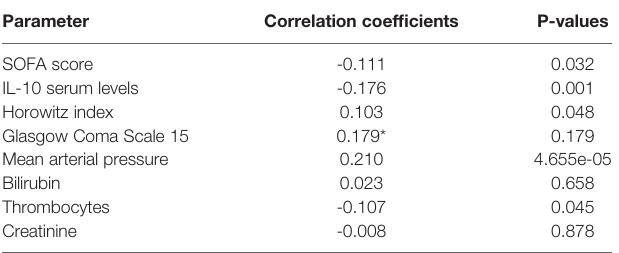
TABLE 1 | Correlation coef fi cients and p-values for the correlation of KLF4 gene expression levels in peripheral blood with SOFA score, SOFA subscores and serum levels of IL-10 in patients with community-acquired pneumonia at admission to hospital. Parameter Correlation coef fi